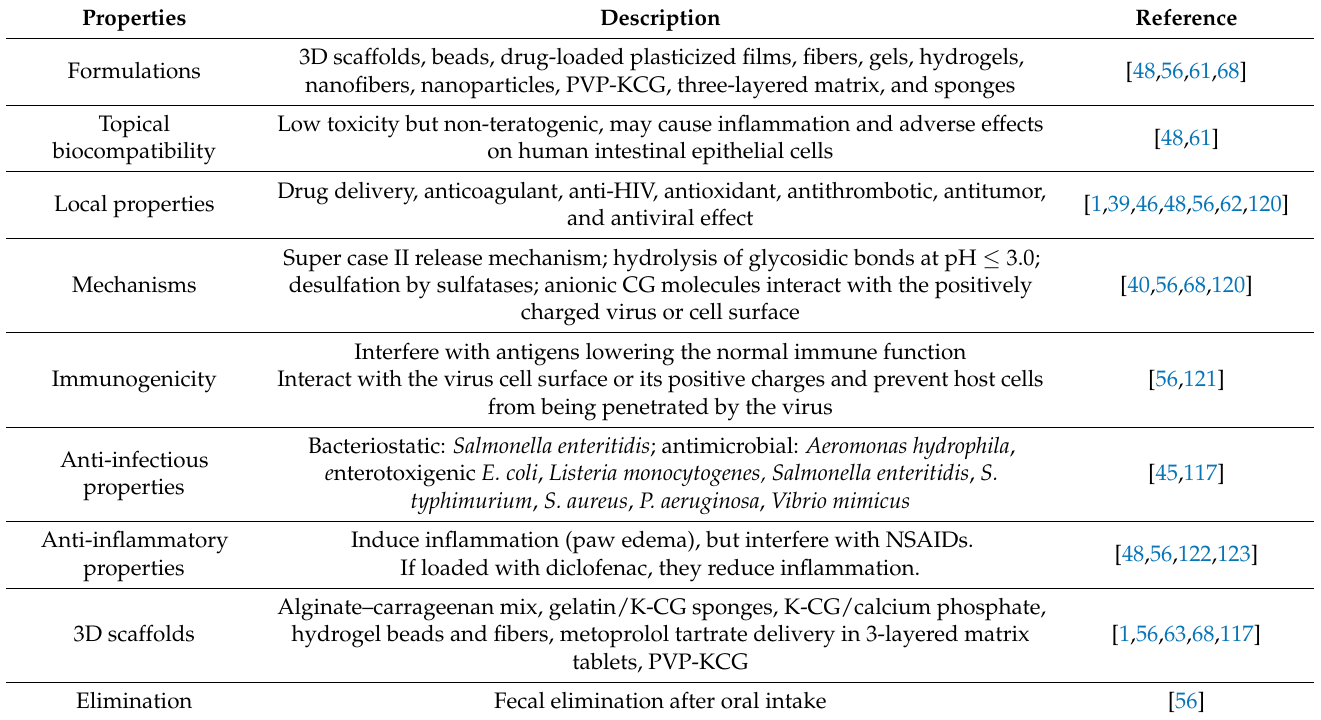
Table 4. Biological characteristics of